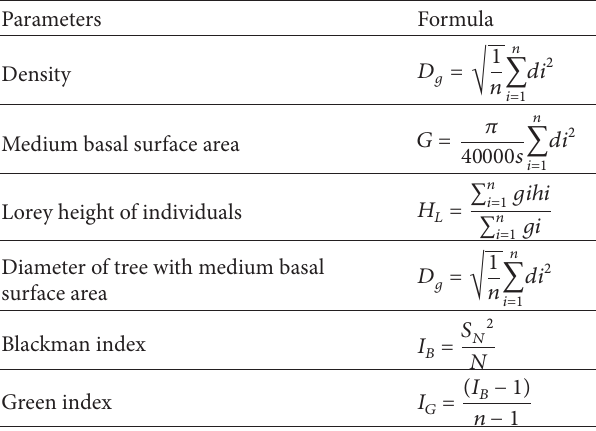
Table 2: Dendrometric parameters and their formula. Parameters